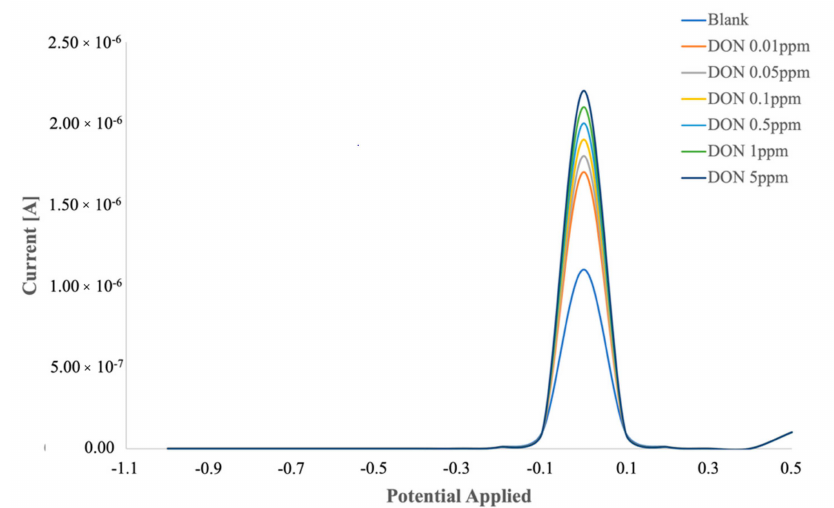
Figure 4. DPV responses of immunosensor to different amounts of DON.